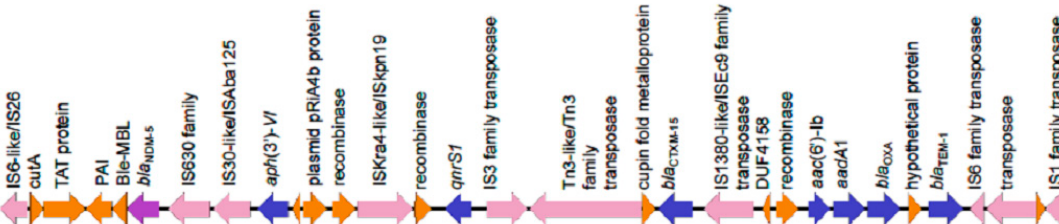
Figure 2. Genes encoded in the region of nt 66471 to 93154 of CP034201, the virulence plasmid of KpvST383_NDM_OXA-48, which includes bla NDM-5 (coloured purple). Other antibiotic resistance genes are shown in blue, while transposons are shown in pink. This same sequence of genes was also found in pKpvST48_1 of Kpv_ST48_NDM (nt 130384 to 156980 of CM016731). Abbreviations are: nt, nucleotide; TAT, twin-arginine translocation pathway signal sequence domain; Ble-MBL, bleomycin-binding protein. Figure created using Easyfig software [14].